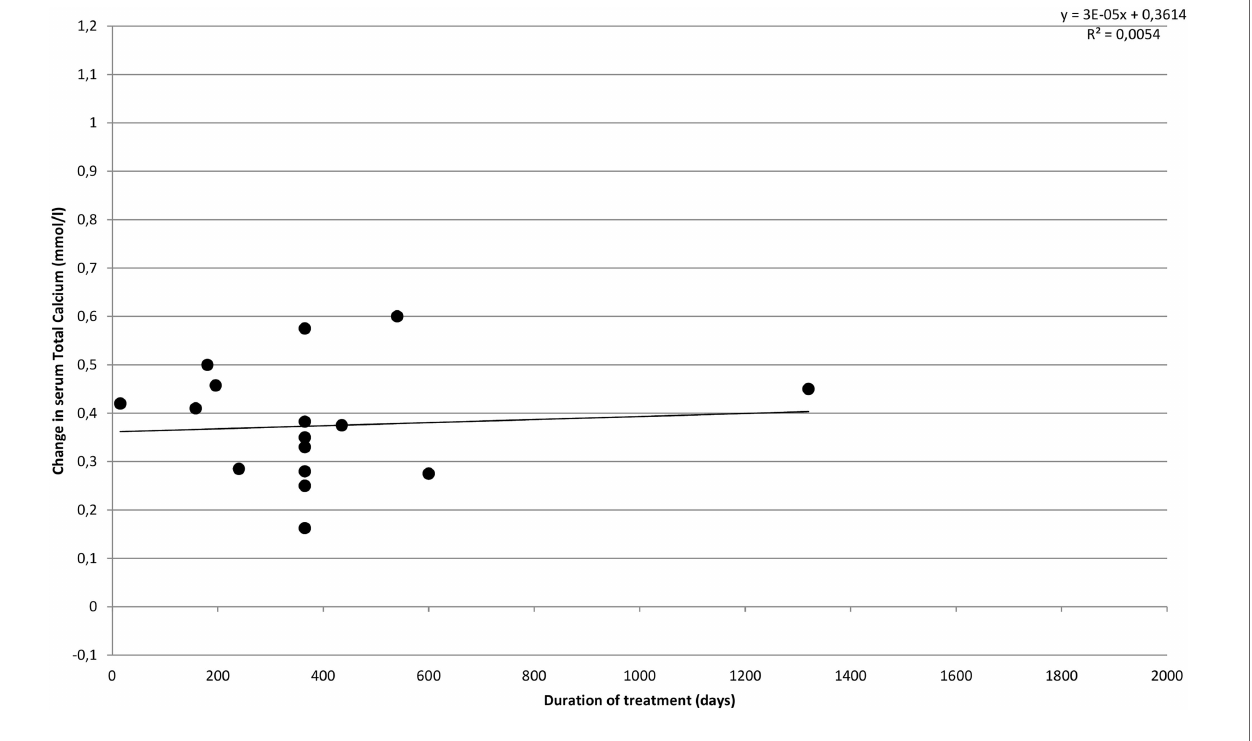
FiGURe 4 | effect of cinacalcet on s-calcium over time